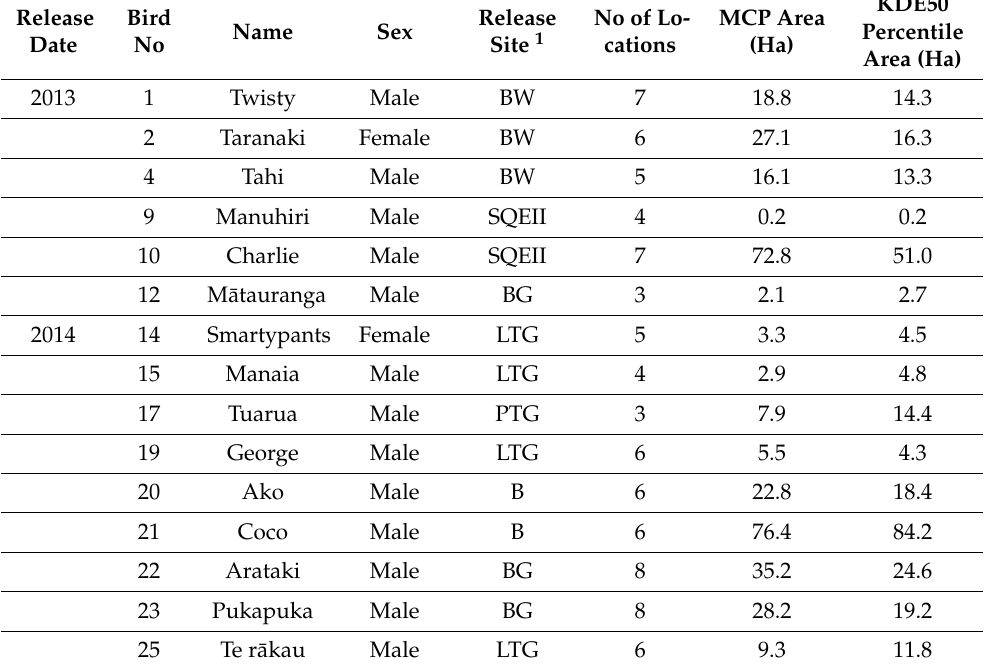
Table 1. Identification, sex, release site, number of locations used for estimating 100% MCP and KDE50 and roost area utilized (ha) by kiwi released in 2013 ( n = 6) and 2014 ( n = 9) as measured by Minimum Convex Polygons (MCP)(ha) and KDE50 (ha) using GIS ArcMET 10.2.2 v3 software for the 12 monitoring days between 13 April and 5 May